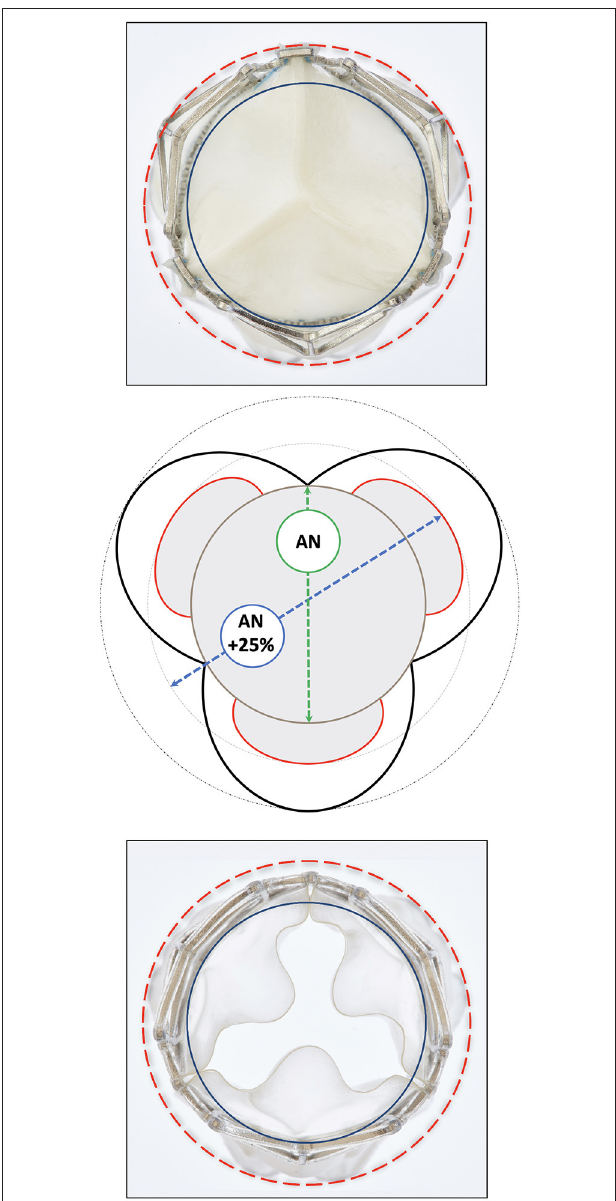
FIGURE 9 | Top view of a deployed SAT bioprosthetic (top) and polymer (bottom) TAVR showing the radius of the supra-annular anchoring-arms (red) vis a vis that at the waist level corresponding with the annular landing zone (blue). The schematic drawing (middle) shows that the supra-annular diameter is 25% bigger than the annular landing zone of the TAVR firmly securing anchorage (pull-out resistance > 23N) even in the absence of calcification. There is still ample space between the arms and the sinus wall in average sinuses of